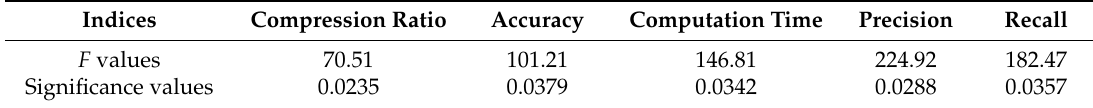
Table 6. The results of statistical tests for all indices based on